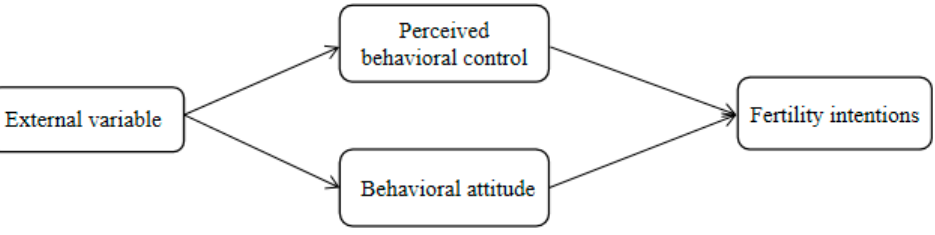
Figure 3. A conceptual model diagram.